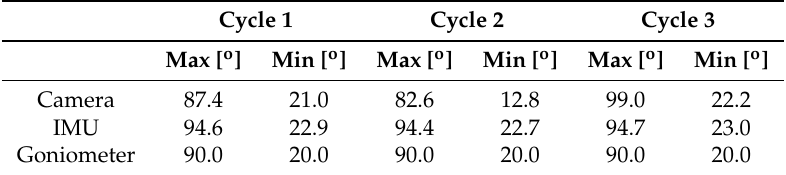
Table 2. Maximum and minimum angles of camera-based system and IMU of each cycle for the first